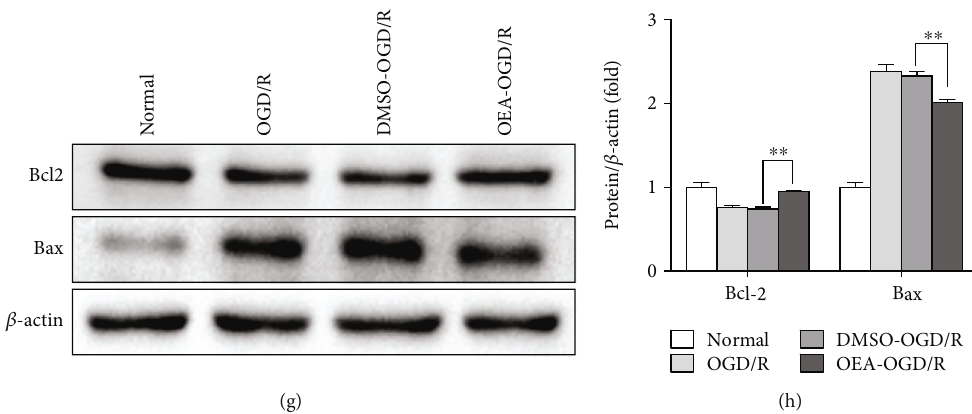
Figure 2: OEA pretreatment attenuates apoptosis in liver I/R injury. (a and b) TUNEL staining and the percentage of TUNEL-positive cells were, respectively, evaluated in the liver sections. (c and d) Cleaved-Caspase3 staining and the percentage of cleaved-caspase3-positive cells were, respectively, evaluated in liver sections. (e and f) Western blotting analysis of Bcl2 and Bax expression in liver tissues. (g and h) Western blotting analysis of Bcl2 and Bax expression in HepG2 cells after OGD/R. ∗∗ p < 0 : 01 and ∗ p < 0 : 05